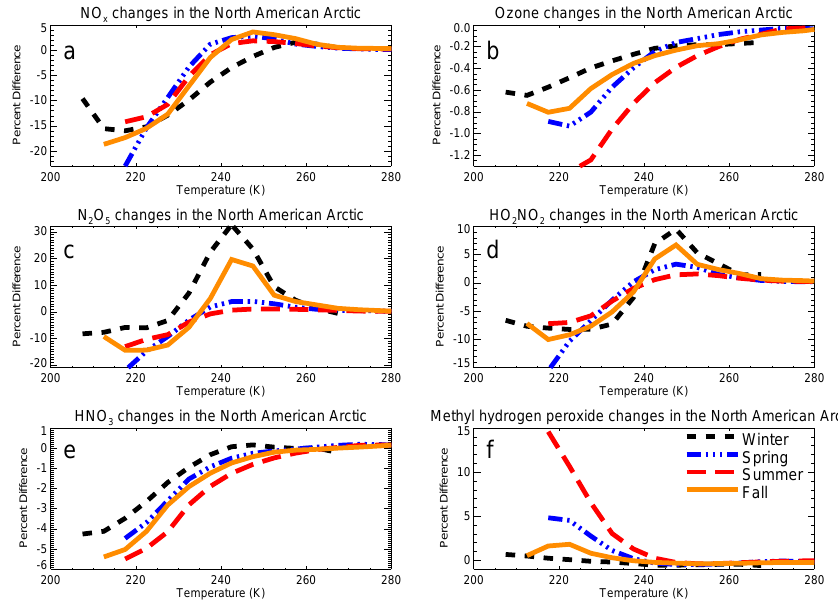
Fig. 4. Differences between the GEOS-Chem base case and MPN case (((MPN-BASE)/BASE)*100) over the North American Arctic versus temperature for (a) NO x , (b) ozone, (c) N 2 O 5 , (d) HO 2 NO 2 , (e) HNO 3 , and (f) methyl hydrogen peroxide. These results are temperature binned means of 24h averaged concentrations.